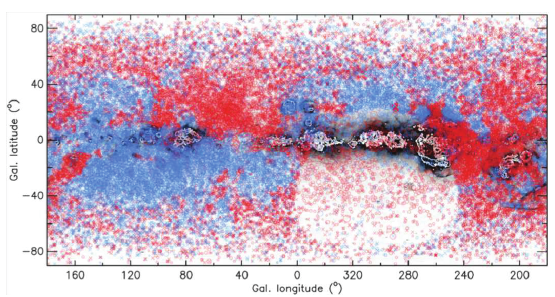
Figure 6. All-sky map in Galactic coordinates (with the Galactic center in the middle) of the RMs of (cid:3) 45000 extragalactic radio point sources from the NVSS ( δ > − 40 ◦ ) and S-PASS ( δ < 0 ◦ ) surveys [26]. Positive (negative) RMs are plotted in red (blue).